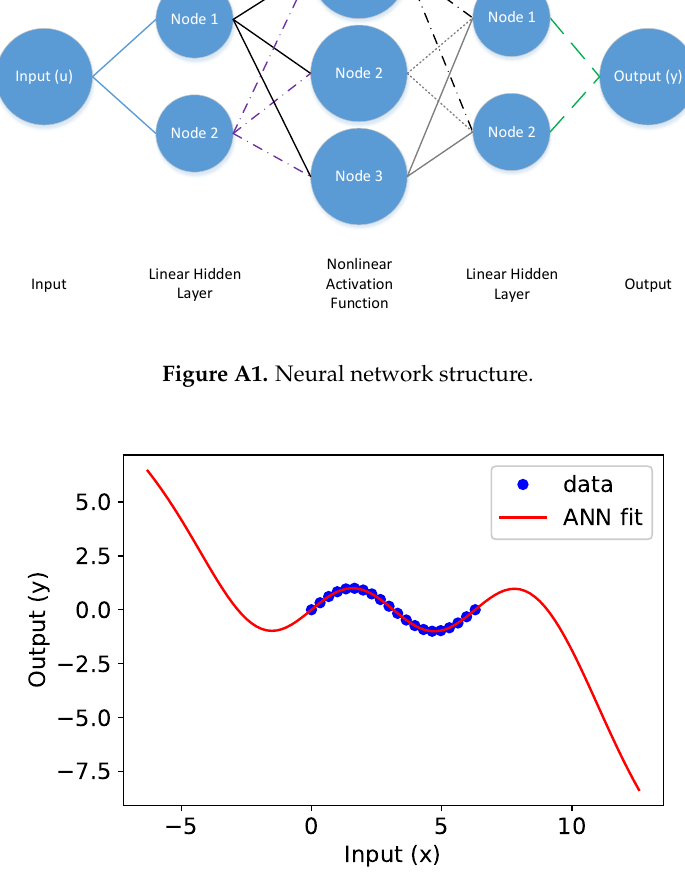
Figure A2. Artificial neural network approximates y = sin ( x )